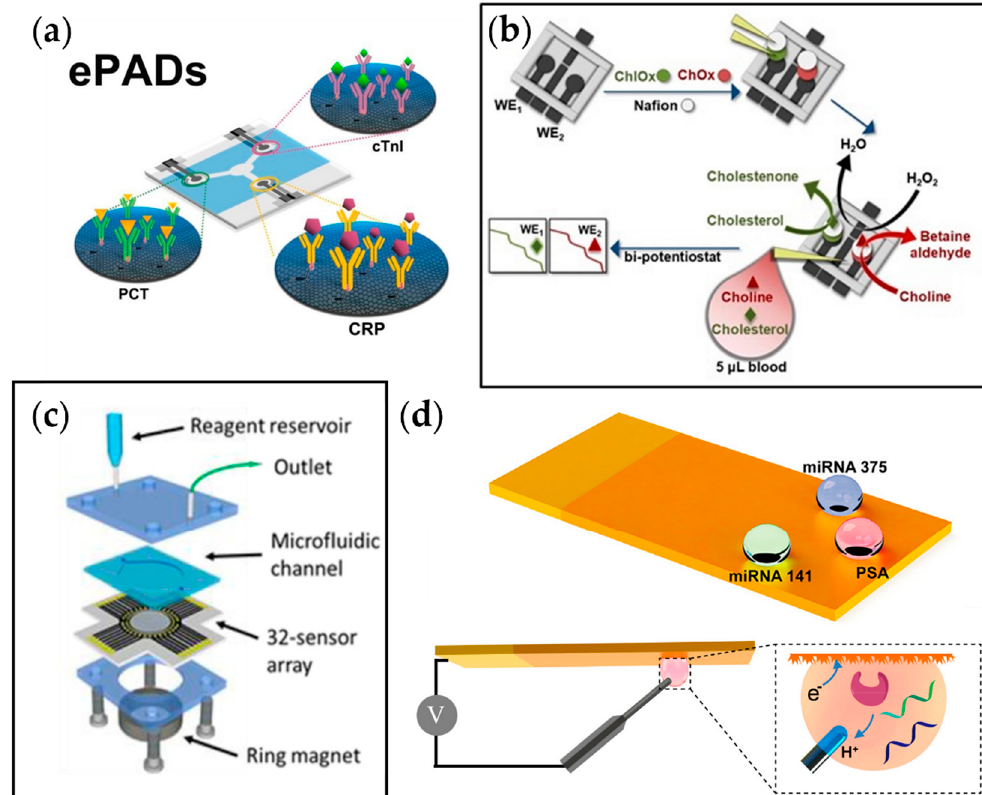
Figure 4. Examples of multiplexed electrochemical sensors for metabolic diseases. ( a ) Multiplexed ePAD for cTnI, PCT, and CRP detection [106]. ( b ) Fabrication process of the 3D printed biosensor for amperometric detection of cholesterol and choline [107]. ( c ) A 32-sensor array with microwells with a microfluidic chamber for simultaneous detection of prostate cancer biomarker proteins [109].